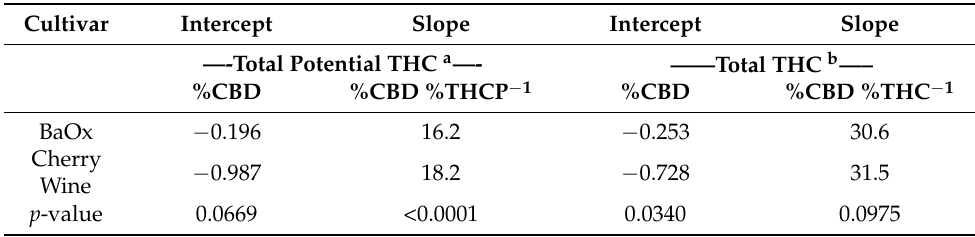
Table 6. Linear regression coefficient estimates for models describing the linear relationship be- tween floral hemp cultivars, total THC concentration, total potential THC concentration, and total CBD concentrations.